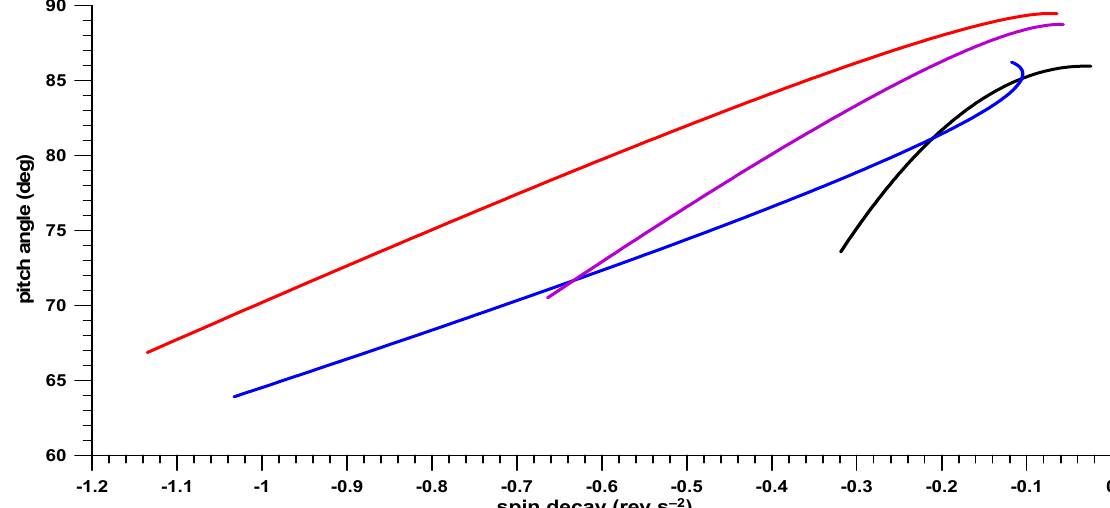
Figure 4. Pitch angle of the spin axis (angular velocity vector) against the spin decay of the 4 Frisbee throws shown in Figure 2 (same colour